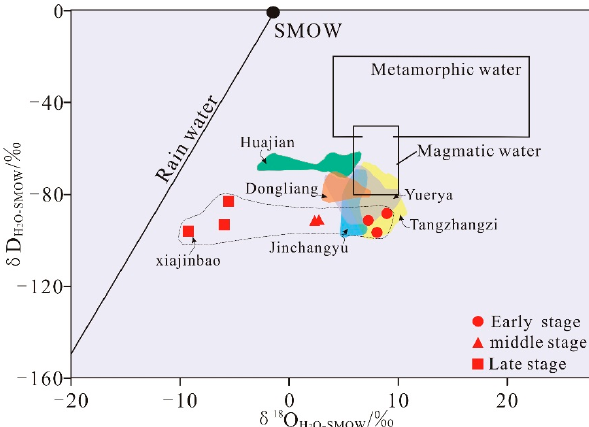
Figure 16. Oxygen and hydrogen isotope compositions of quartz and ore-forming fluids from the Jidong gold deposits. Oxygen and hydrogen isotope data of the Huajian deposit are from Shi [41] and Wang [54]; Oxygen and hydrogen isotope data of the Dongliang deposit are from Xin et al. [42]; Oxygen and hydrogen isotope data of the Jinchangyu deposit are from Zhang et al. [55]; Oxygen and hydrogen isotope data of the Yuerya deposit are from Jie [56]; Oxygen and hydrogen isotope data of the Tangzhangzi deposit are from He [57].